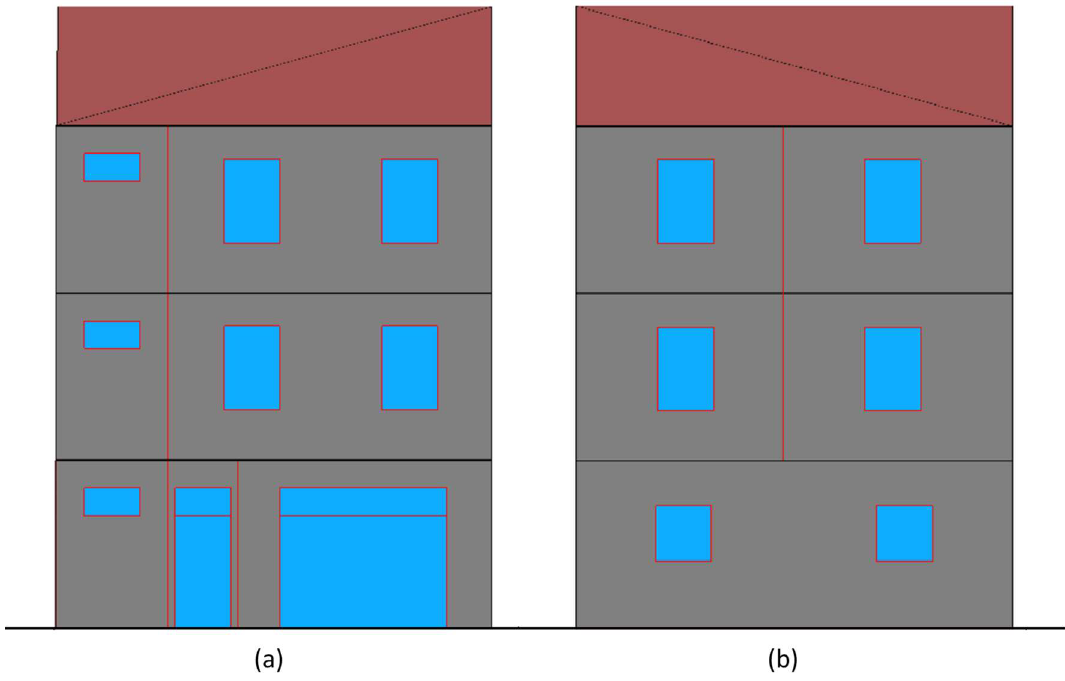
Figure 2. View of the study building: ( a ) south façade and ( b ) north façade.